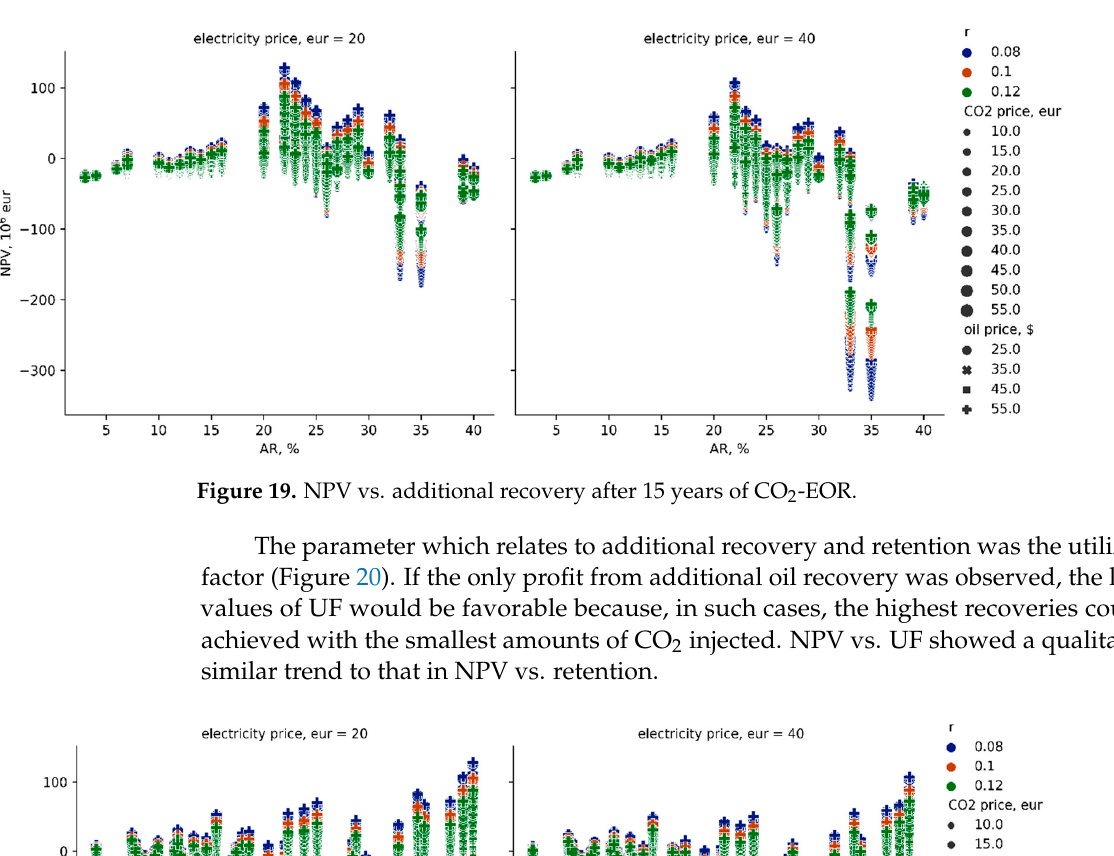
19 of 29 Figure 18. NPV versus retention after 15 years of CO 2 EOR for different discount rates, oil and CO 2 prices, and two different